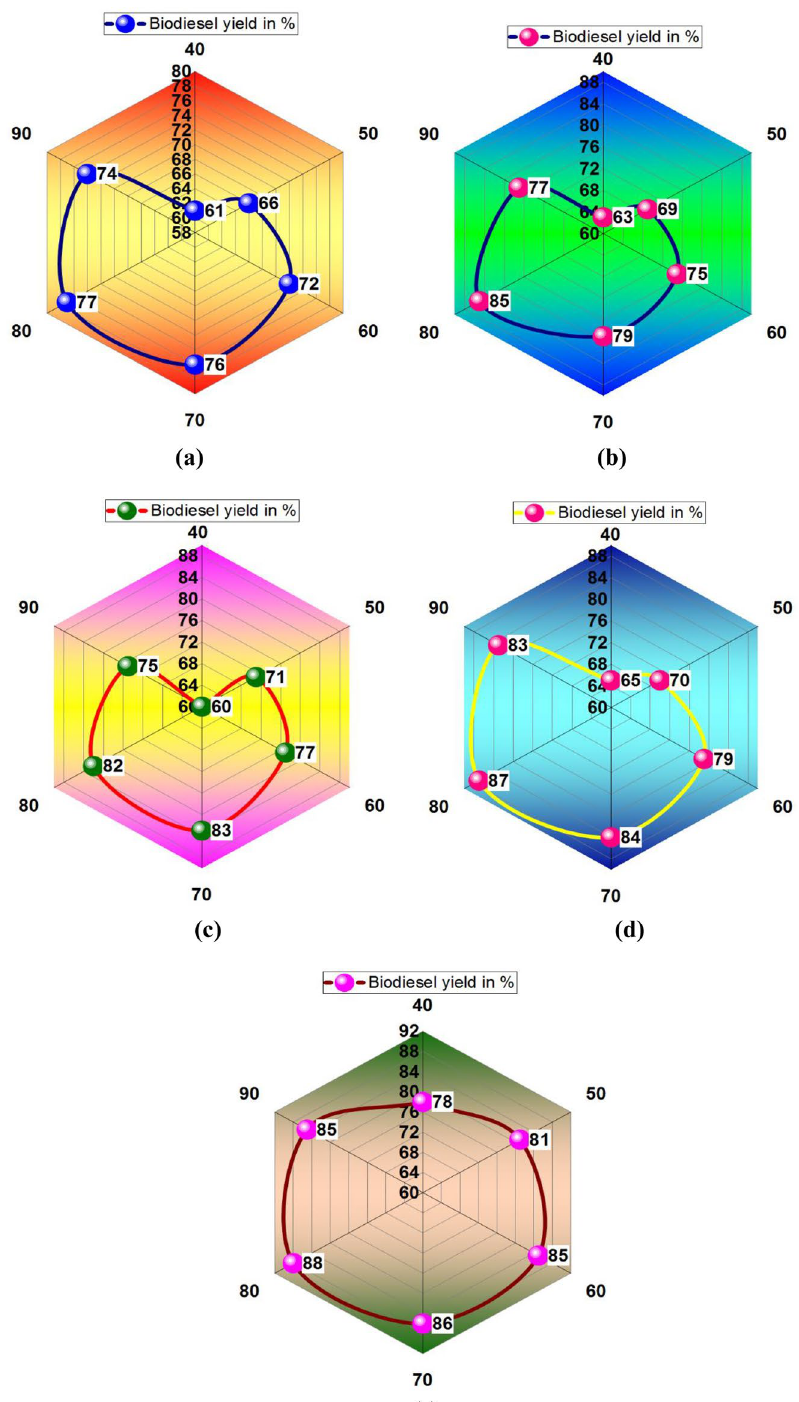
Figure 4. Reaction temperature vs. biodiesel yield in % using of plant waste: ( a ) Bagasse ( b ) Papaya stem ( c ) Banana peduncle ( d ) Moringa oleifera ( e ) Mixed